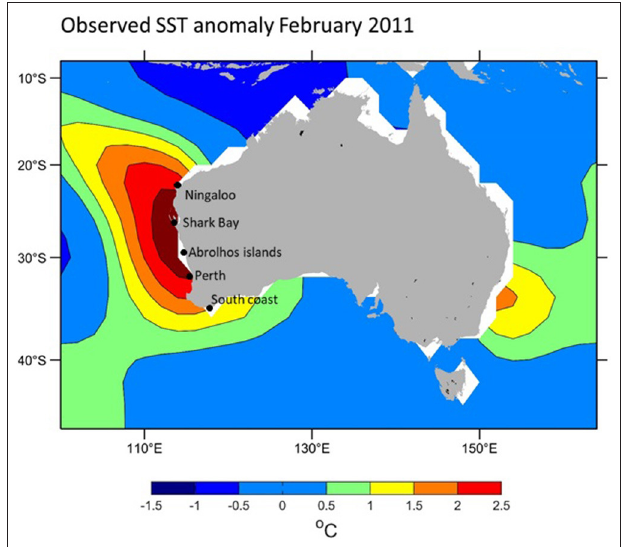
FIGURE 1 | Sea surface temperature anomalies in February 2011 at the peak of the 2010–2011 marine heatwave, derived from NOAA Extended Reconstructed SST version 5 (ERSSTv5) ( Huang et al.,